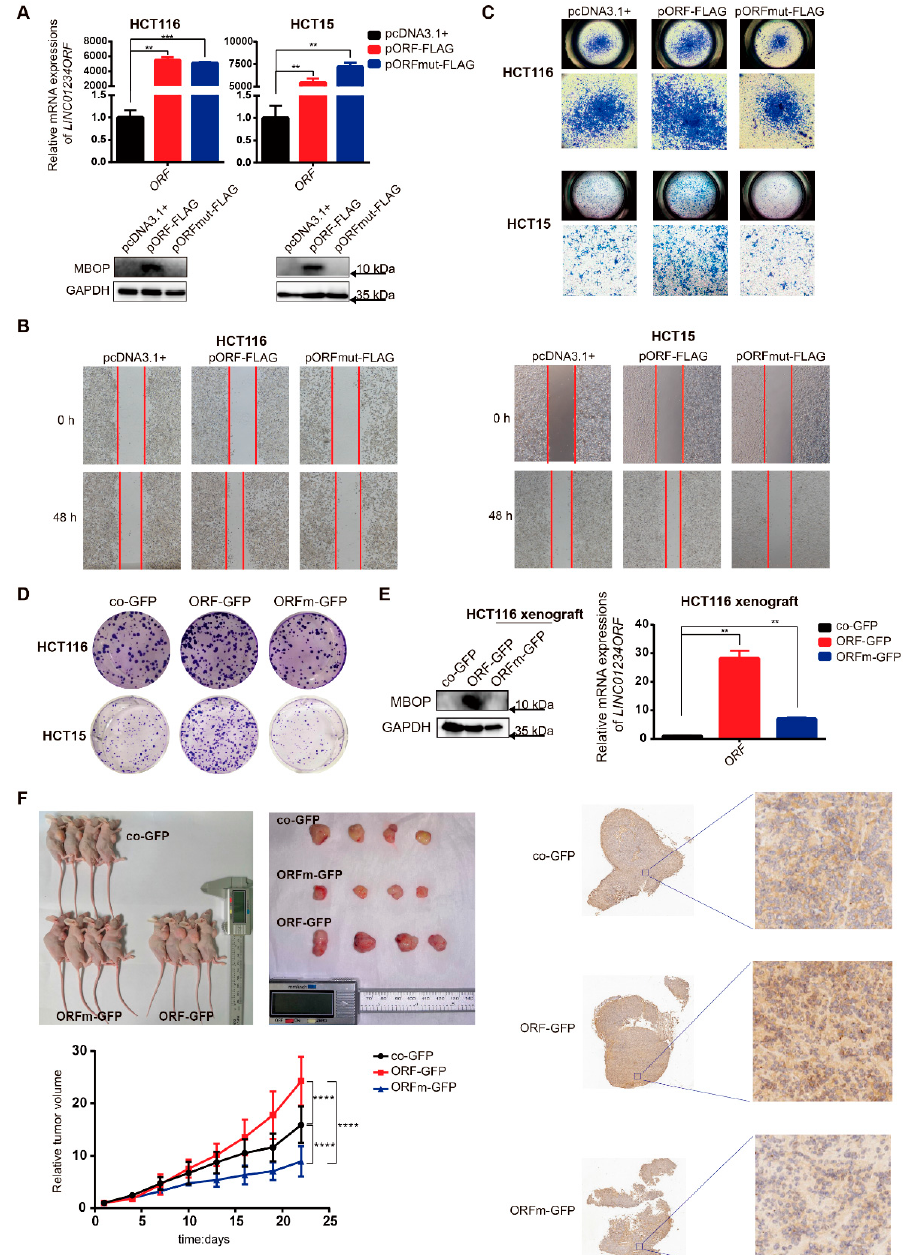
Figure 3. MBOP promotes CRC progression through cell migration and proliferation. ( A ) Representa- tive images of expressions of LINC01234ORF and MBOP in HCT116 and HCT15 after transfection of series plasmids pcDNA3.1+, pORF-FLAG, and pORFmut-FLAG. Data are presented as mean ± SD, ** p < 0.005, *** p < 0.0005. ( B ) Migration ability of cells transfected with series plasmids pcDNA3.1+, pORF-FLAG, and pORFmut-FLAG were detected with wound healing assay. ( C ) Migration ability of cells transfected with series plasmids pcDNA3.1+, pORF-FLAG, and pORFmut-FLAG were detected with transwell assay. ( D ) Colony formation assays of lentiviral transfected cell lines co-GFP, ORF-GFP, and ORFm-GFP. ( E ) The mRNA and protein expressions of MBOP from primary tumors resulted from in vivo plant of lentiviral transfected HCT116 cell lines co-GFP, ORF-GFP, and ORFm-GFP. Data are presented as mean ± SD, ** p < 0.005. ( F ) Mice bearing tumor fragments derived from primary tumors of ( E ), and the relative tumor volumes were recorded ( n = 4). Data are presented as mean ± SD, **** p < 0.0001. The representative images of the immunohistochemistry assay are shown in the right